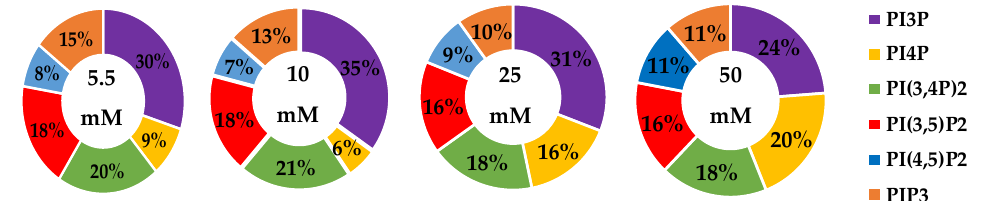
Figure 2. Effect of Glucose Concentration on ER+/PR+ breast cancer total PI phosphorylation. The % of total PI lipid PI3P, PI4P, PI(3,4)P2, PI(4,5)P2, PI(3,5)P2, and PIP3 from MCF7s incubated in 5.5 mM, 10 mM, 25 mM, and 50 mM serum glucose concentrations, measured by spot blot analysis ( n = 3). Table 2. Statistical analysis of whole cell lipidome in MCF7 Cell Line.